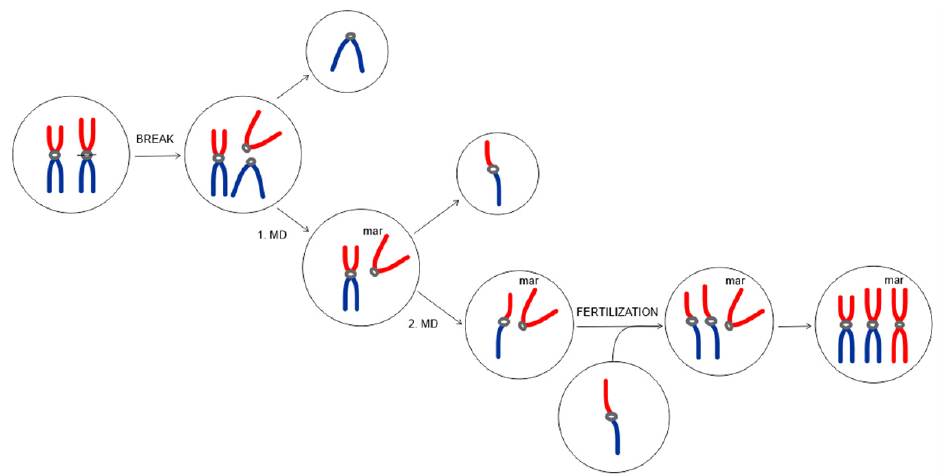
Figure 7. Schematic reconstruction showing the most possible marker formation during meiosis. The initial break in the (peri)centromeric region of one of the EMA27 homologs led to the horizontal separation of the p- and q-arms producing two isochromosomes, i(27p) and i(27q). One product of the misdivision was the sSMC formed by heterochromatic p-arms, i(27p). The other product was formed by the q-arms of the chromosome, i(27q). During the first meiotic division (MD), the marker along with the normal EMA27 chromosome segregated into one daughter cell. During the second MD, the sister chromatids of the normal EMA27 were released and segregated from one another. The marker chromosome along with one of the normal EMA27 chromatids segregated into the daughter cell, giving rise to an abnormal gamete, and leading to the abnormal zygote with the heterochromatic sSMC after